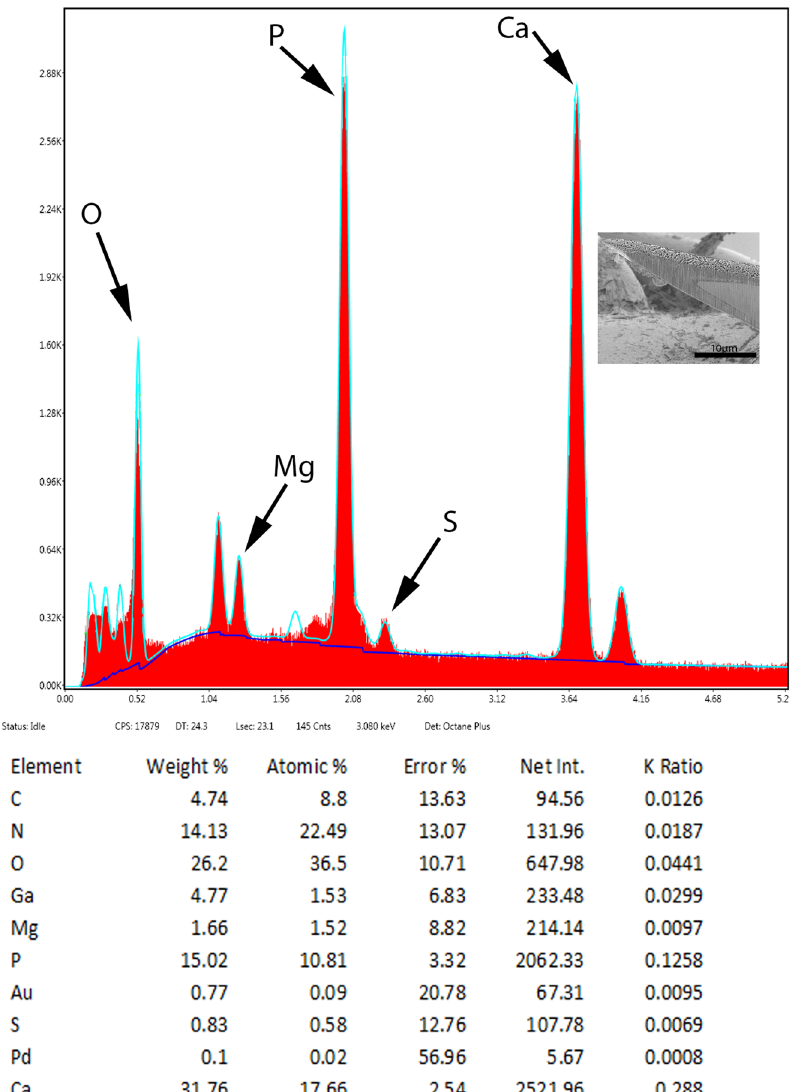
Figure 27. X-ray elemental scan (XEDS) of a Cavisoma magnum hook. Center base of a longitudinal gallium cut showing typical levels of phosphorus, calcium and sulfur content.